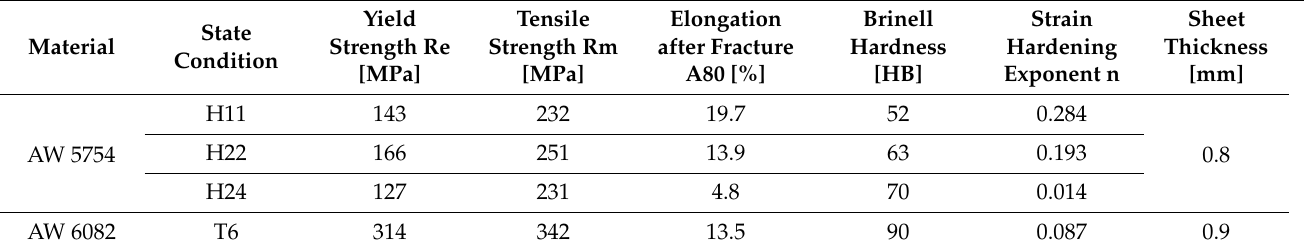
Table 1. Mechanical properties and state conditions of the aluminum alloy